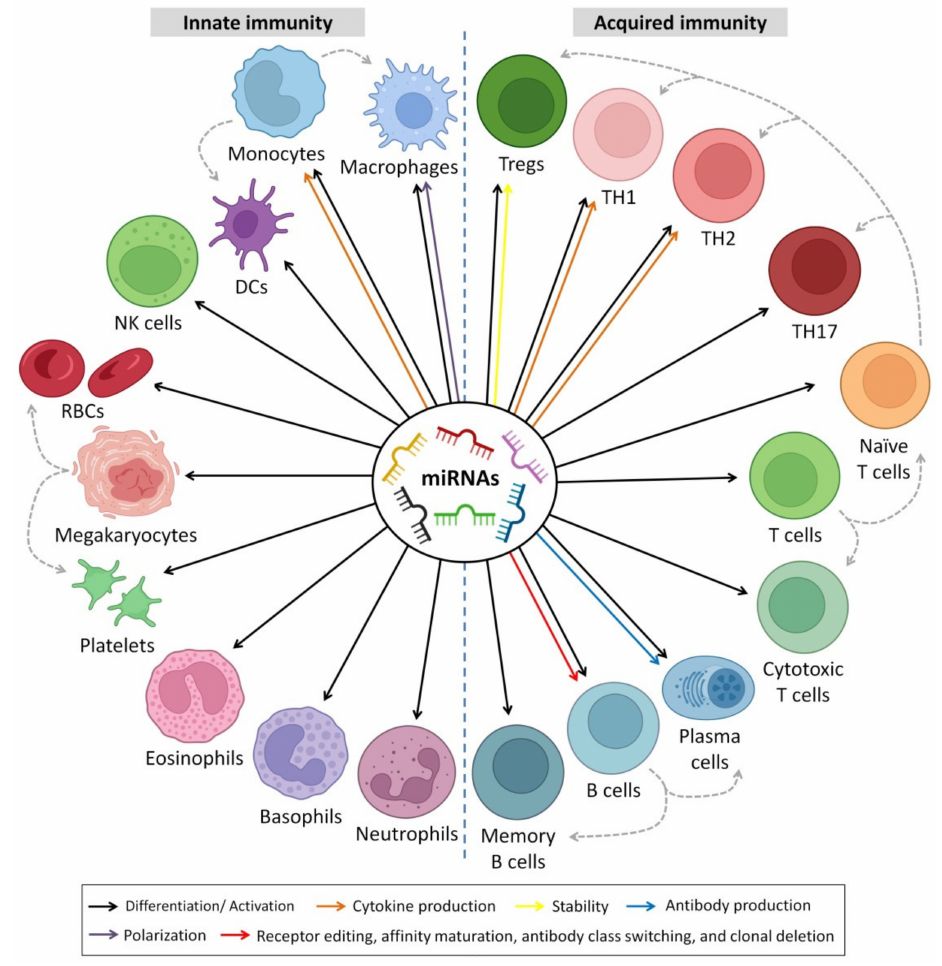
Figure 6. Immunomodulatory actions of HBM-derived miRNAs in both innate and acquired immu- nity. HBM-derived miRNAs are emerging as key controllers of signaling, differentiation and functions of immune cells, especially T cells. Many miRNAs target cytokine genes in monocytes, T helper type 1 (Th1) and Th2 cells regulating the expression of these cytokines and their circulating levels. Other miRNAs present in HBM have also shown a variety of immunomodulatory actions towards immune cells. For instance, miR-10a is a key regulator of regulatory T cell (T regs ) specialization and stability. Furthermore, miRNAs not only have the potential to regulate B cell development and functions, but some of them regulate the production of immunoglobulin by plasma cells (e.g., miR-155). Other miRNAs exquisitely regulate receptor editing during B cell maturation (e.g., miR-17 ∼ 92 cluster), clonal deletion (e.g., miR-148a), antibody class switching to IgG and secretion of IgE in B cells (e.g., miR-146a). Moreover, HBM-derived miRNAs affect other than-immune system components that par- ticipate in innate and adaptive immunity. For example, miR-146 regulates the megakaryocytopoiesis process, which produces platelets and red blood cells (RBCs). miR-27b affects the functions and reactivity pathways of platelets that release inflammatory and bioactive molecules and has some immune functions such as engulfing microbes. Further, miR-142 may affect the survival and functions of RBCs that act as modulators of innate immunity, especially by binding and scavenging specific molecules that mediate inflammatory responses (such as mitochondrial DNA and chemokines) in circulation [51,129,604–615]. Created with BioRender.com, accessed on 22 April 2022. HBM-derived miRNAs play a substantial role in the early immune system maturation of infants. Several studies have examined the relationship between miRNAs and innate and adaptive immunological responses [603,616]. According to the Pathway Central database’ annotation (SABiosciences, Frederick, MD, USA), 4 of the top 10 most frequently